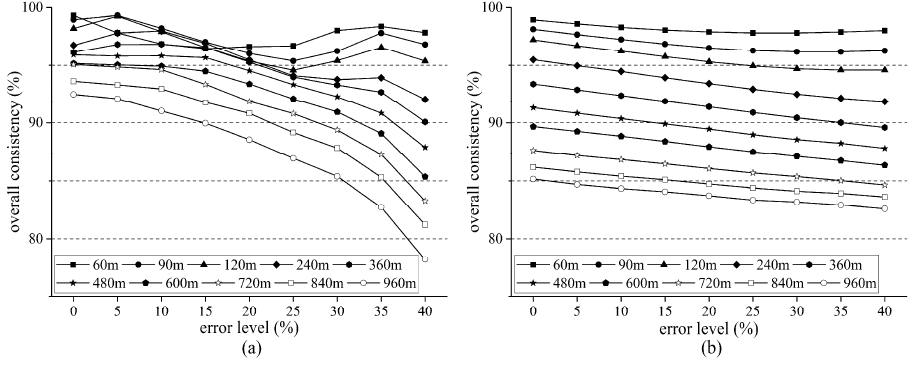
Figure 8. Overall consistency (OC) performance with different error level: ( a ) the results in ASD1810; and ( b ) the results in ASD4550.